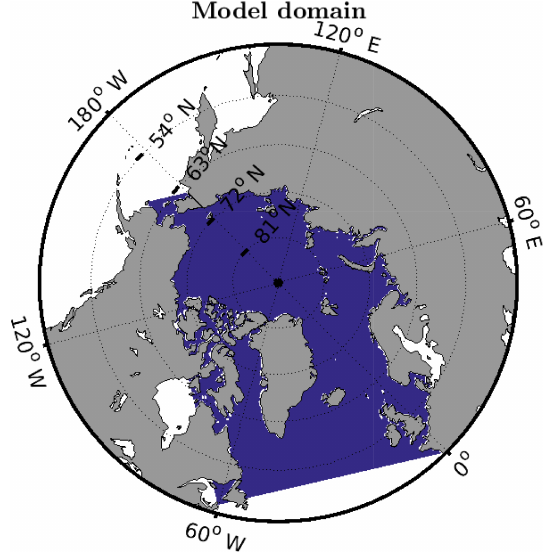
Figure 1. The model domain: the blue area is covered by the model and grey indicates land